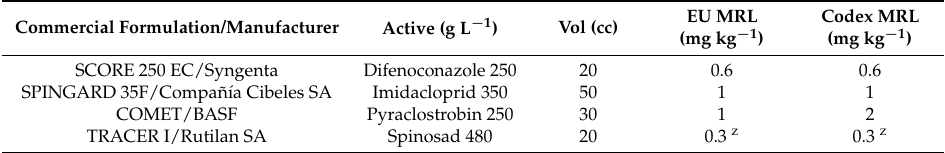
Table 1. Pesticides evaluated and rate per 100 L. European Union (EU) and Codex Alimentarius Maximum Residue Levels (MRL) for each analyte in mandarin. Vol: